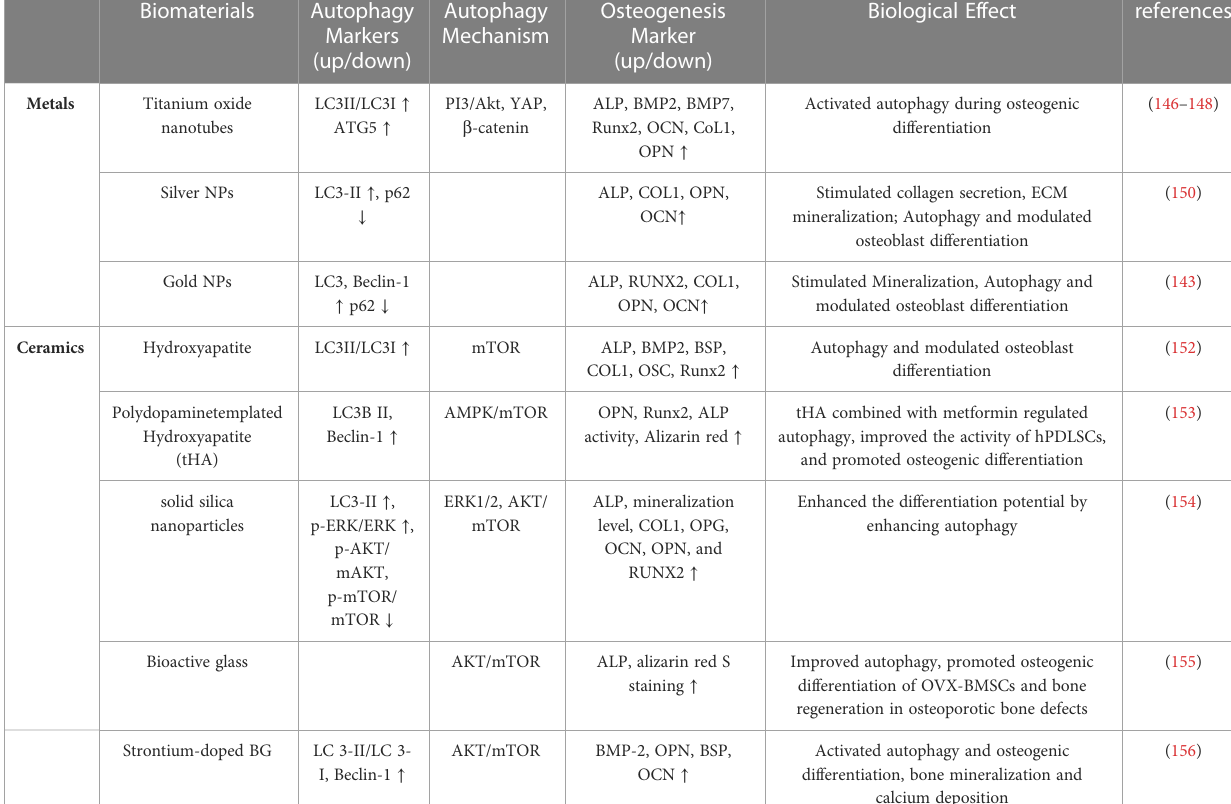
TABLE 1 Targeting autophagy: A promising therapy for osteogenesis.